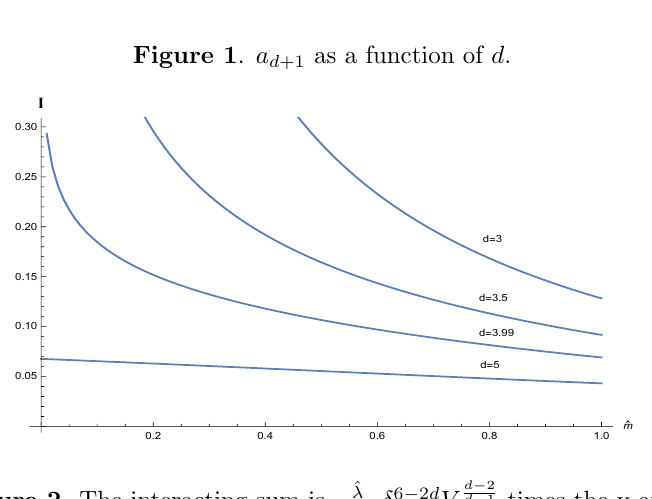
Figure 2 . The interacting sum